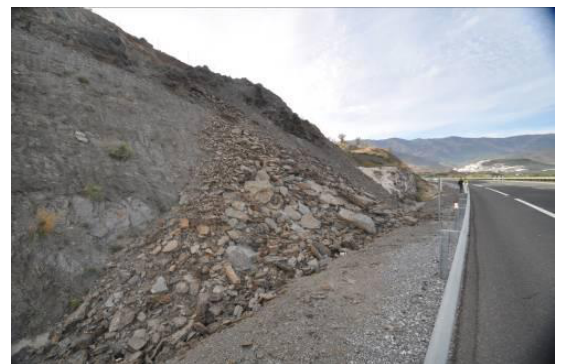
Figure 4. Landslide detail with the contention wall in the second plane of the image